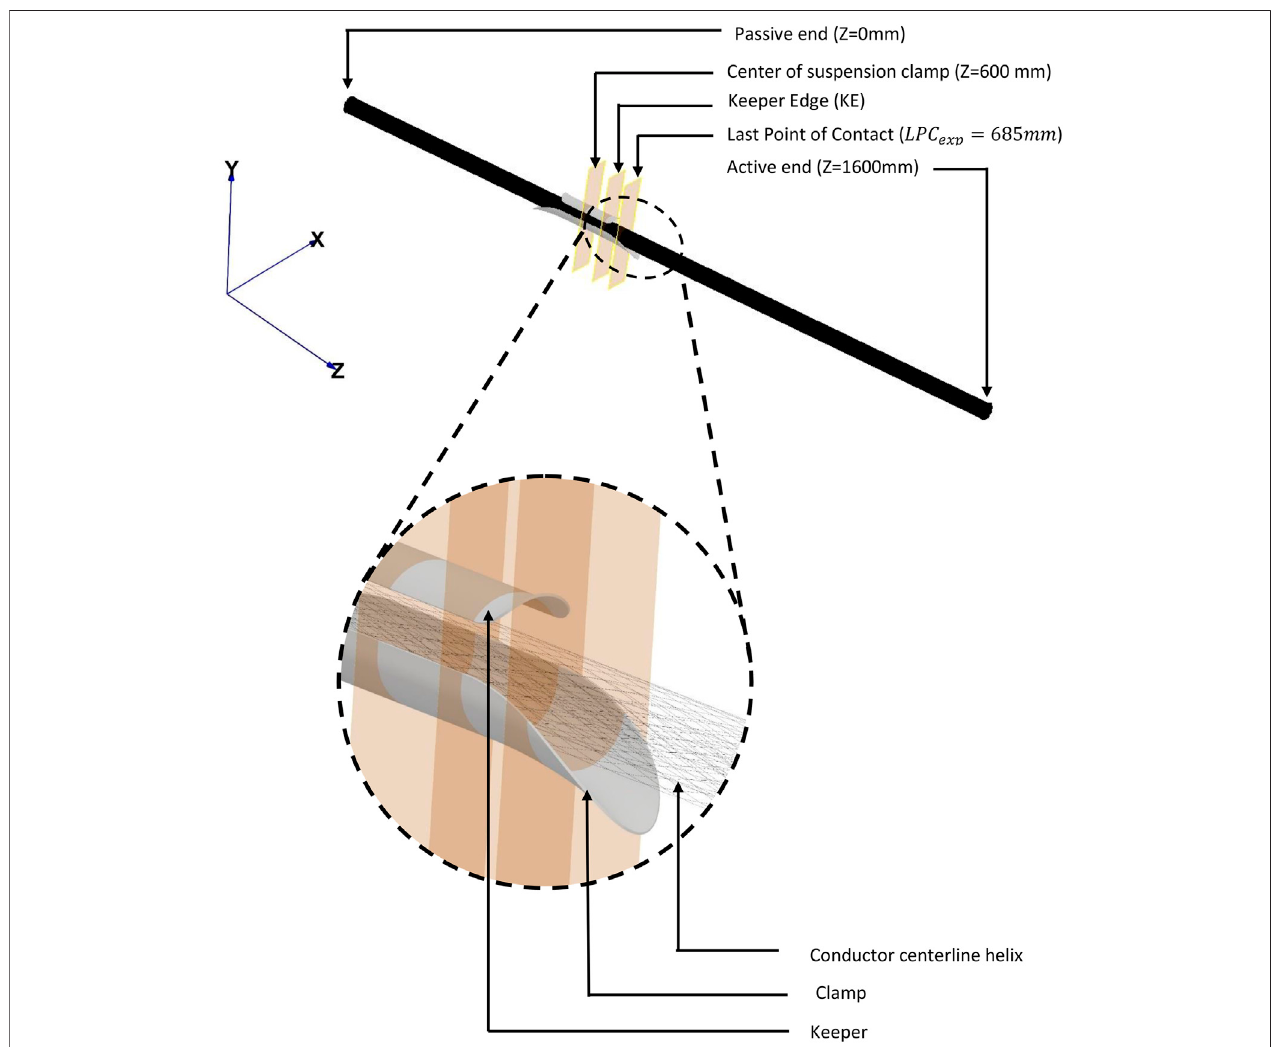
FIGURE 3 | Geometric representation of the Bersfort conductor-clamp